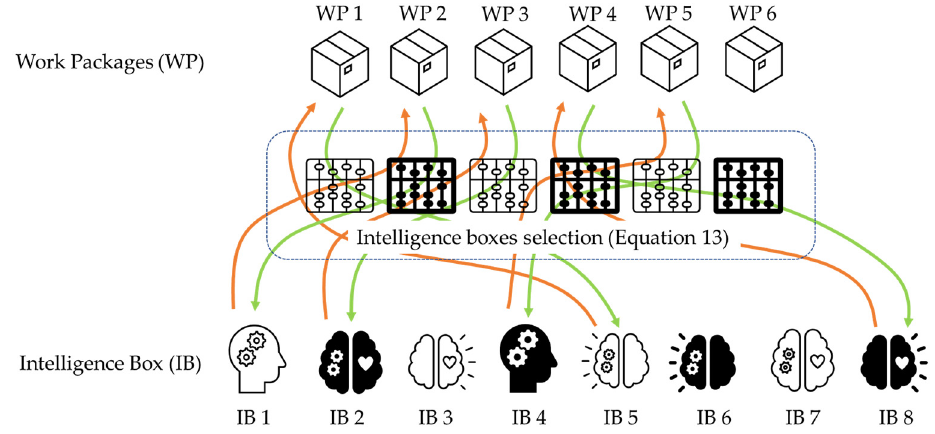
Figure 3. Framework of the AMIS.